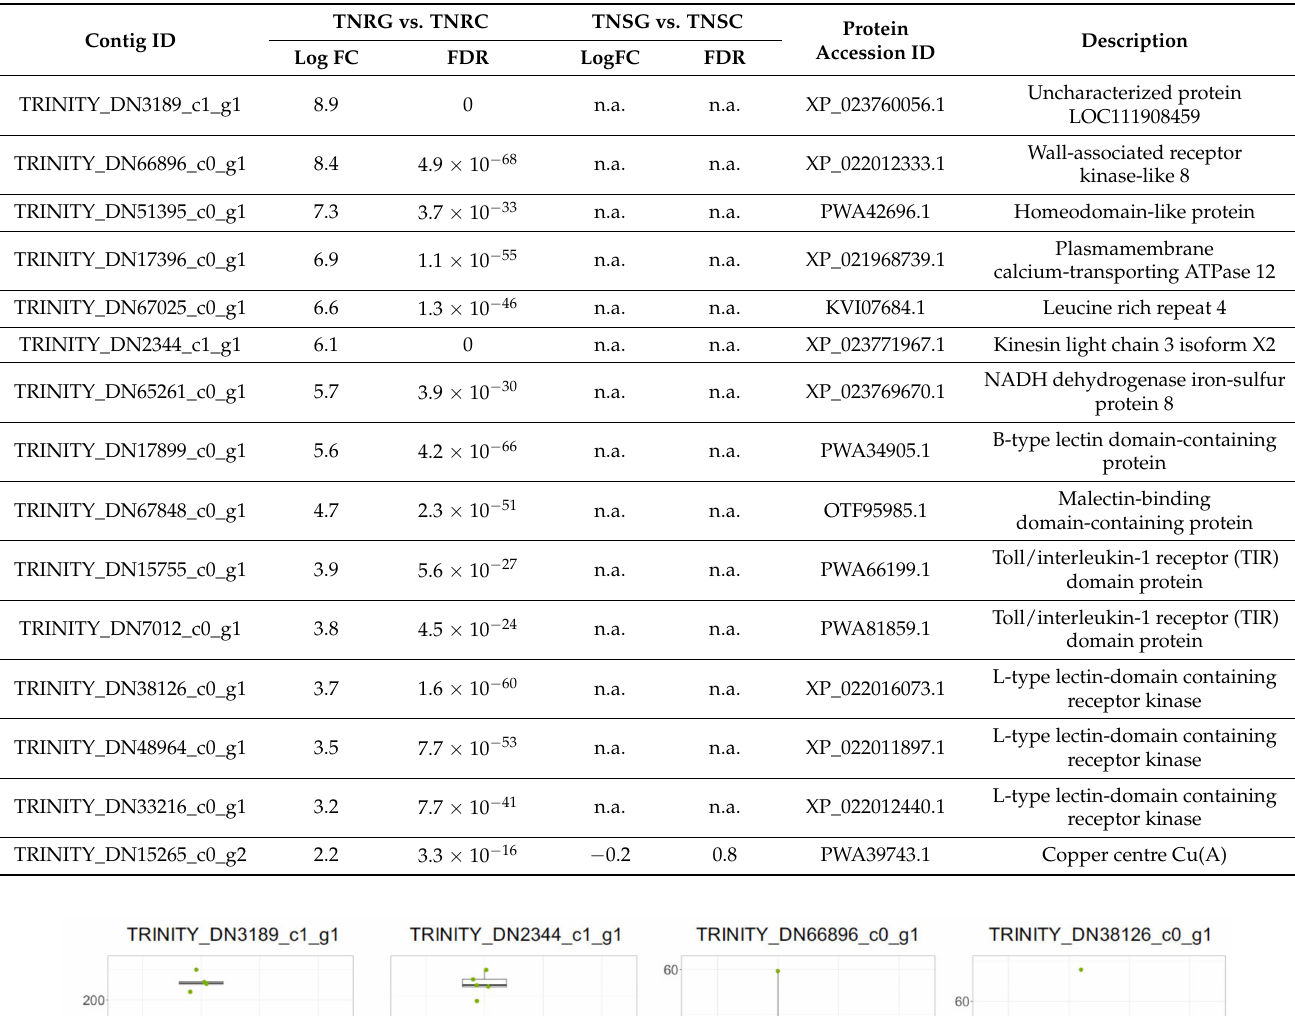
Table 6. Gene list of upregulated genes only in TNRG. These genes were expressed in TNR but not in TNS after glyphosate treatment (FDR < 0.05). Thirty-three genes were filtered by removing the gene expressed with small read counts (<20) from 517 upregulated genes only in TNR. Of these genes, 15 genes had corresponding protein accession numbers in Blast X. This table lists these 15 genes (n.a. = not available).